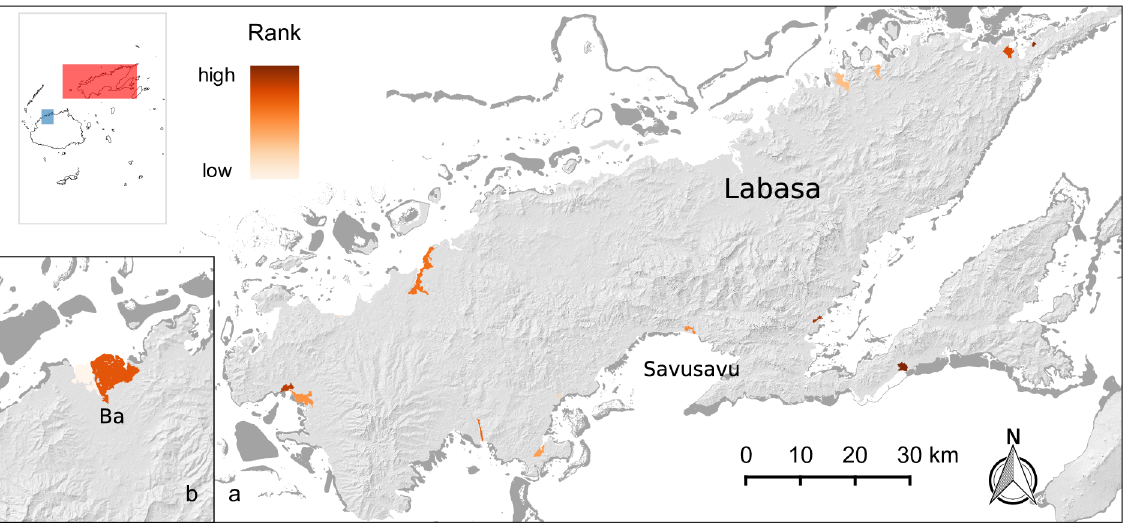
Fig 7. Carbon storage priority mangroves. The majority of the 19 priority areas were on the island of Vanua Levu, where population and development is generally lower (panel a, red inset polygon). Several large priority areas are found on Viti Levu, however; for example, around the large mangrove stands near the mouth of the Ba river (panel b, blue inset polygon). Dark grey areas are coral